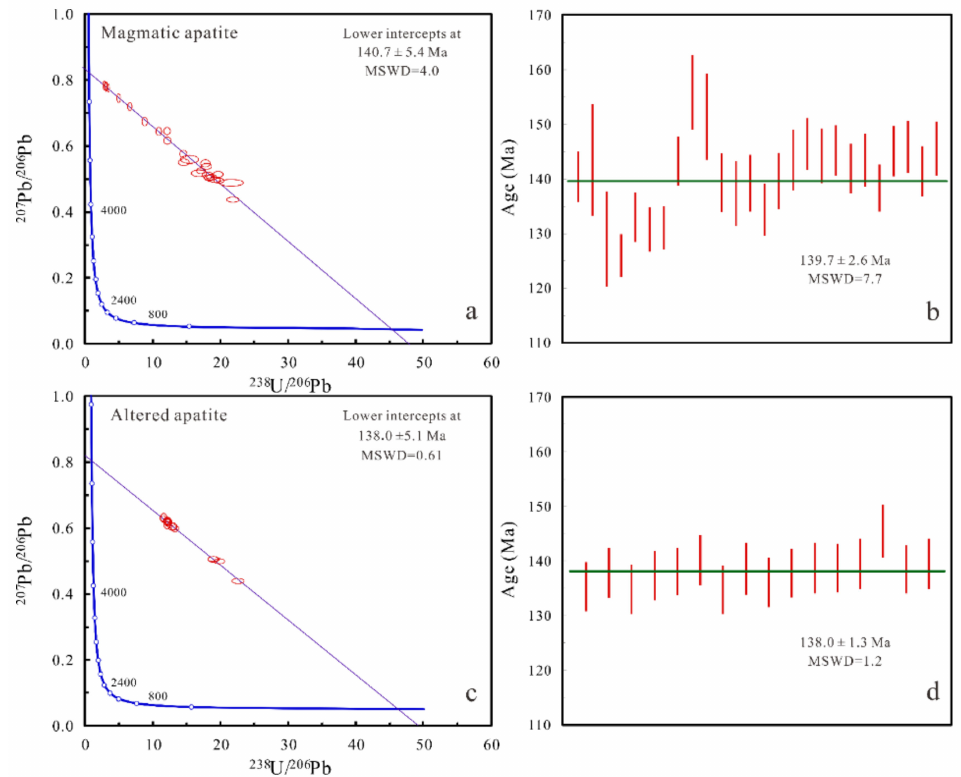
Figure 11. Tera–Wasserburg plots and weighted mean 206 Pb/ 238 U age diagrams for magmatic and altered apatite within magnetite-apatite-enriched